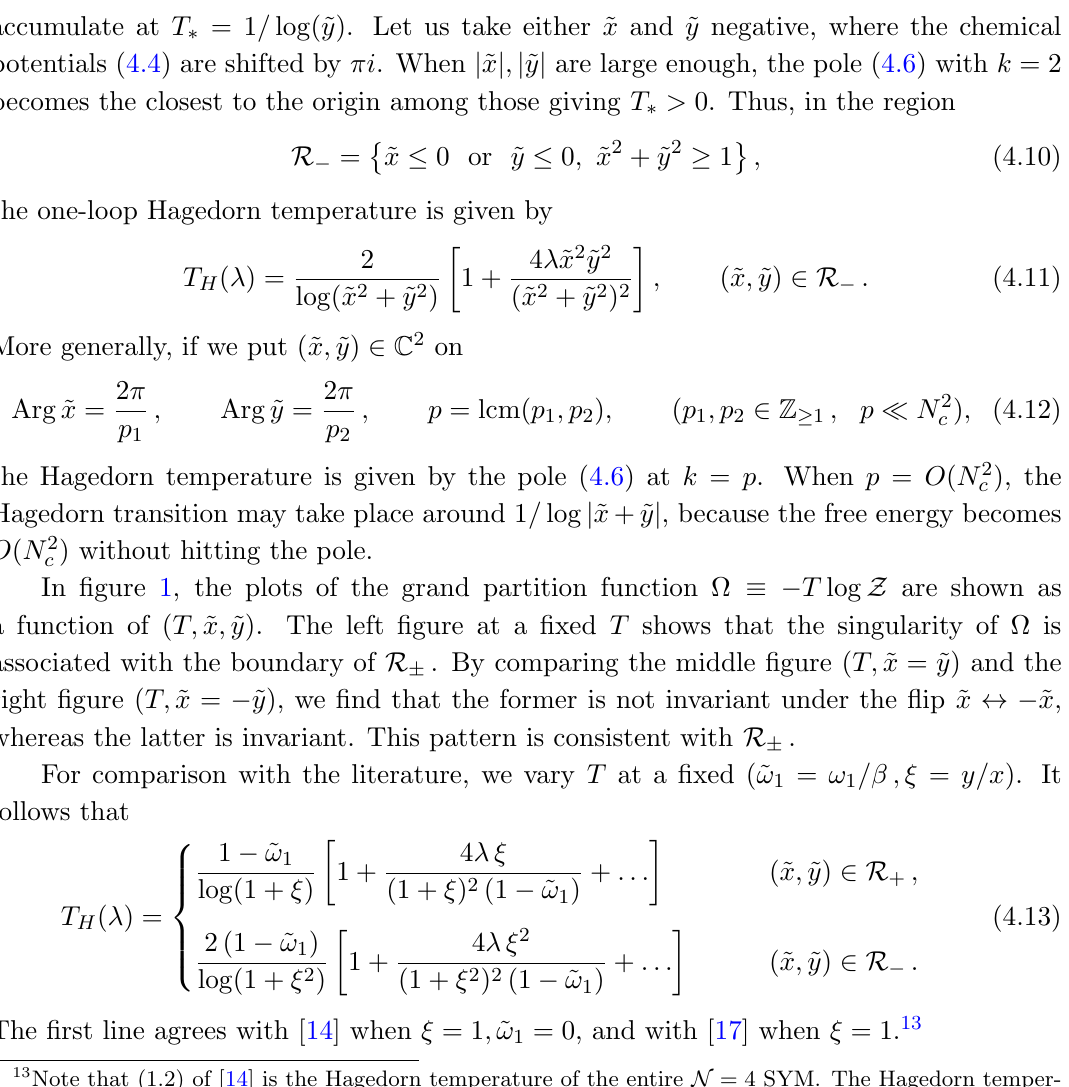
Figure 1 . Plots of Re (cid:10) at (cid:21) = 0 : 05. The left (cid:12)gure shows the plot with ( T = 5 = 3 ; ~ x; ~ y ), the middle (cid:12)gure with ( T; ~ x = ~ y ), and the right (cid:12)gure with ( T; ~ x = (cid:0) ~ y